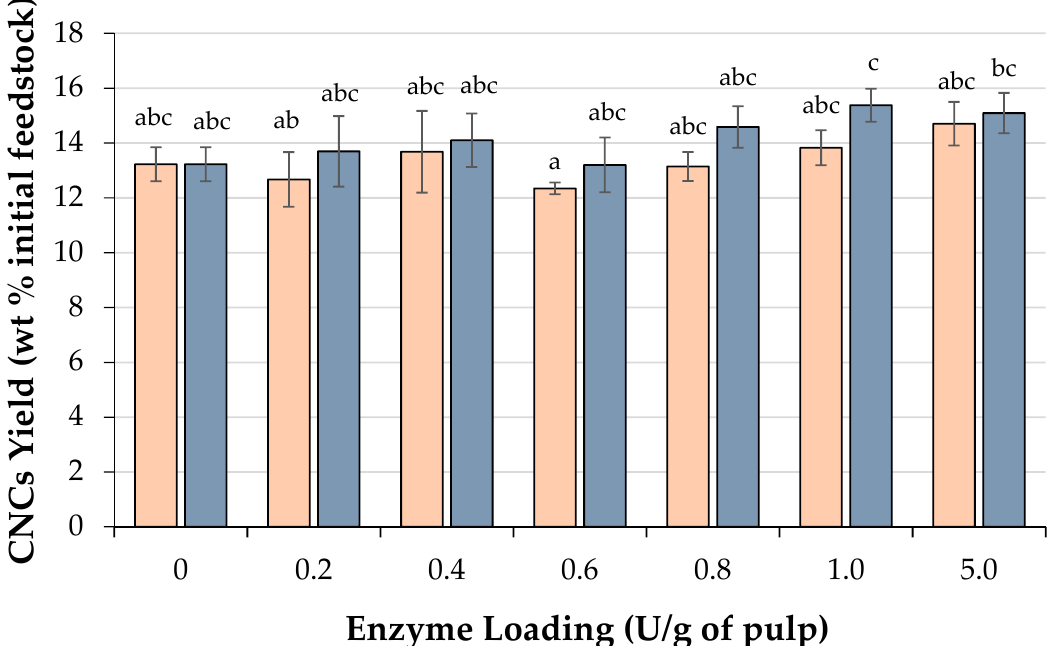
Figure 3. CNC yield of the overall endoglucanase enzymatically-mediated acid hydrolysis process. The yield from the initial feedstock was calculated by taking into account the mass loss due to endoglucanase enzymatic treatment. Columns labelled with different letters indicate means that are statistically different at a 95% confidence level.